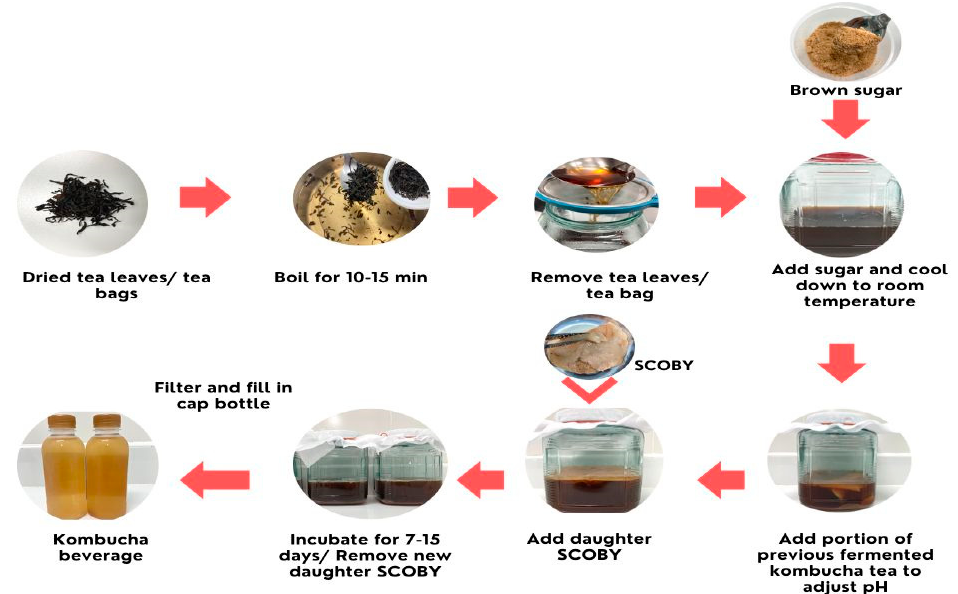
Figure 1. The production process of kombucha beverages (modified from Jayabalan et al. [4]; Kaewkod et al. [14]; Jakubczyk et al.